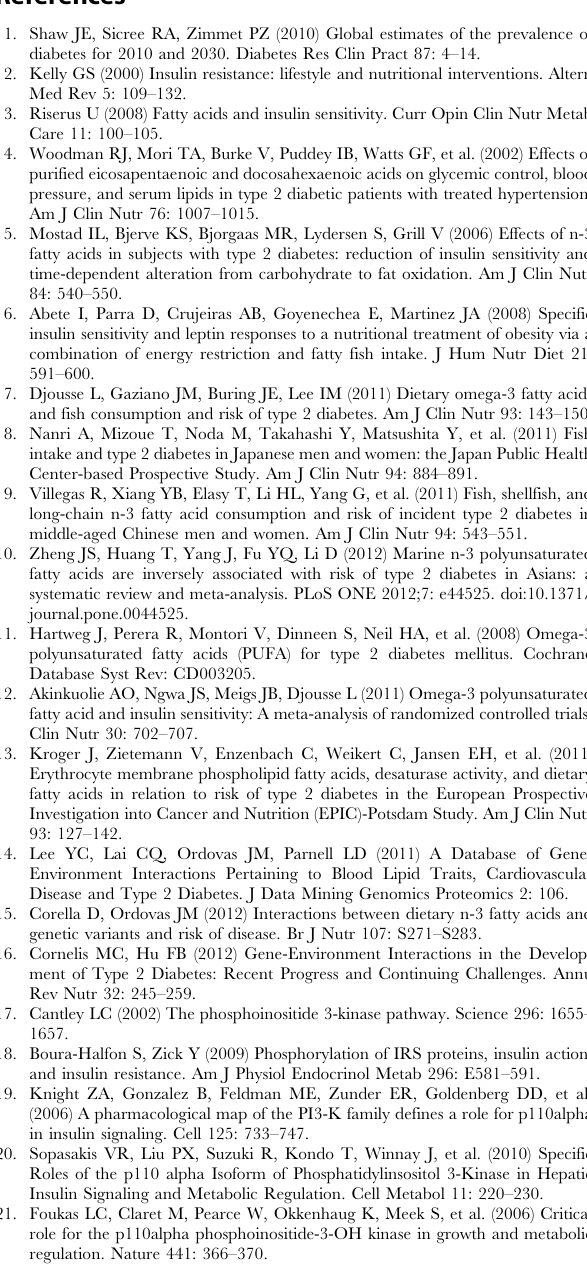
variants in the region. The numbers inside the diamonds indicate the r 2 value. Table S1 Description of selected variants in PIK3CA- KCNMB3 region in GOLDN. Table S2 Interactions between dietary PUFA and rs1183319 on fasting glucose and HbA1c in the BPRHS participants. Table S3 Variance contributions of PIK3CA-KCNMB3 variants and their interaction with dietary n-3: n-6 PUFA ratio for HOMA-IR in